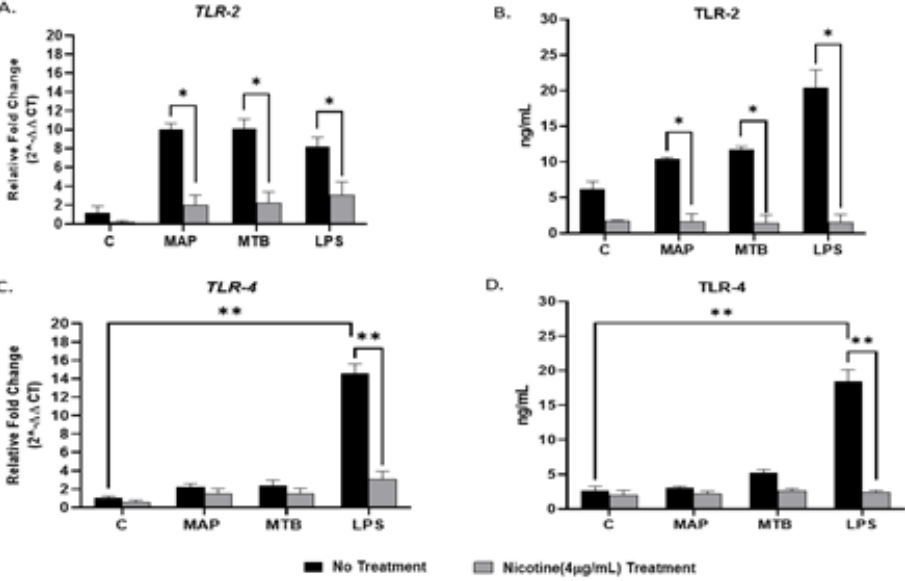
Figure 1. Effect of nicotine on the TLR2 / TLR4 expression on infected macrophages. THP-1 PMA differentiated macrophages were infected with MAP and MTB, or treated with LPS for 24 h, then treated with nicotine (4 µg/mL). Expression of TLR2 ( A,B ) and TLR4 ( C,D )were measured by RT-PCR and ELISA, respectively. All experiments were performed in duplicates. MAP: Mycobacterium avium paratuberculosis. MTB: Mycobacteria tubercalusis. LPS: lipopolysaccharide derived from Escherichia coli ATCC 8739. * p < 0.05, ** p < 0.001.